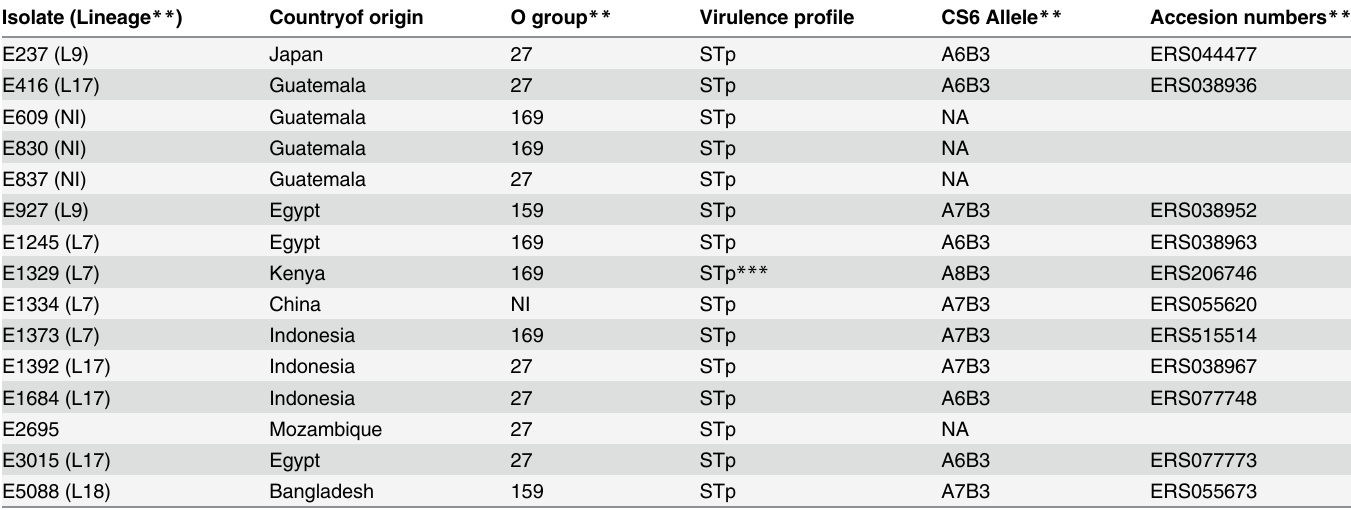
Table 1. CS6+STp expressing ETEC isolates used in this study * .